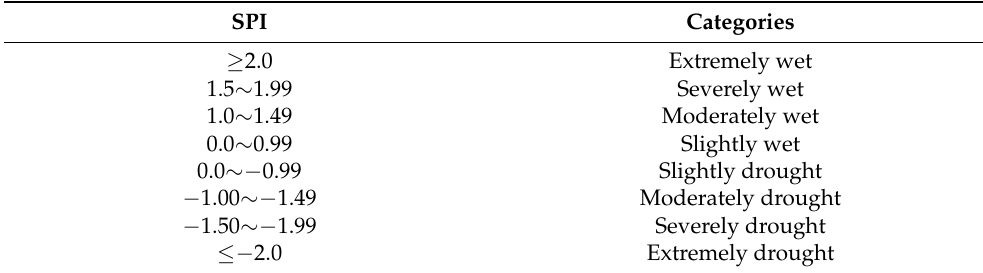
Table 1. SPI drought category classification [13,29,30].